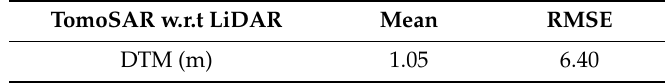
Table 4. The mean and RMSE of the underlying topography estimated by the W&O-SPICE TomoSAR method with respect to the LiDAR